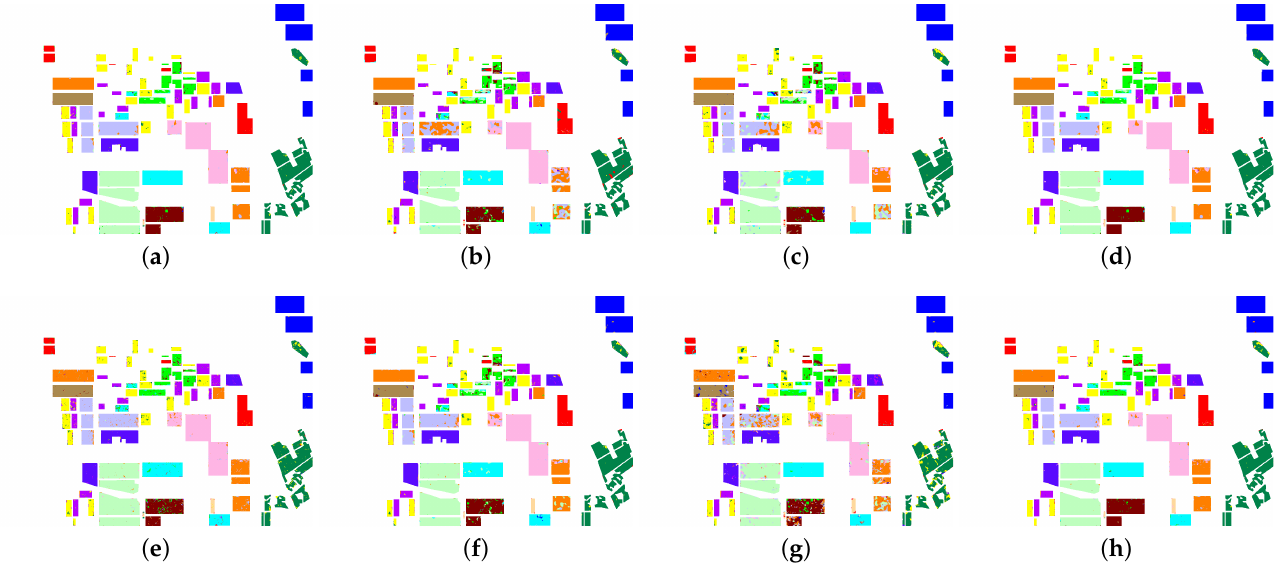
Figure 7. Prediction result of Flevoland image obtained by different methods, including ( a ) SVM on the learned parameters, ( b ) SVM on all the parameters, ( c ) ANN on the learned parameters, ( d ) ANN on all the parameters, ( e ) AE on the learned parameters, ( f ) AE on all the parameters, ( g ) AEFT on the learned parameters, and ( h ) AEFT on all the